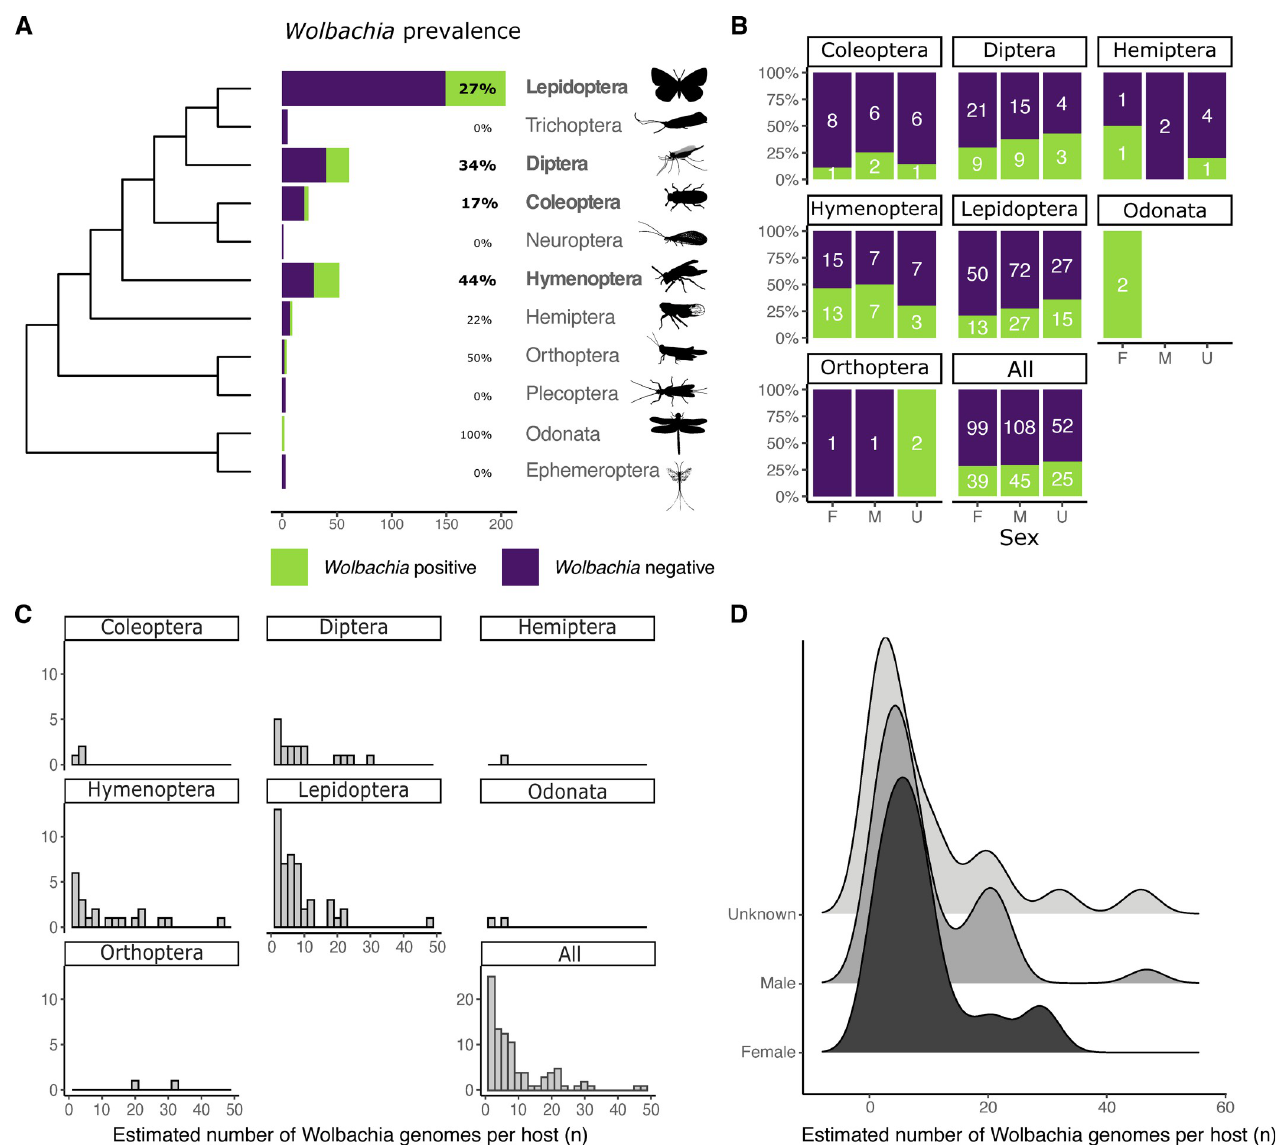
Fig 1. Prevalence and relative abundance of Wolbachia in DToL insect genomes. (A, B) Prevalence of Wolbachia in insect hosts, split by taxonomic order ( A ) and by sex ( B ). The cladogram of insect ordinal relationships is based on Misof and colleagues [28]. Orders with more than 10 analysed species are shown in bold. Silhouettes are from PhyloPic (http://phylopic.org/). Sex of insects was classified as F (female), M (male), or U (unknown, where not recorded on collection). The data underlying this Figure can be found in S1 Data. (C, D) The estimated number of Wolbachia genomes per copy of the host nuclear genome split by taxonomic order ( C ) and by sex ( D ). The data underlying this Figure can be found in S1 Data.